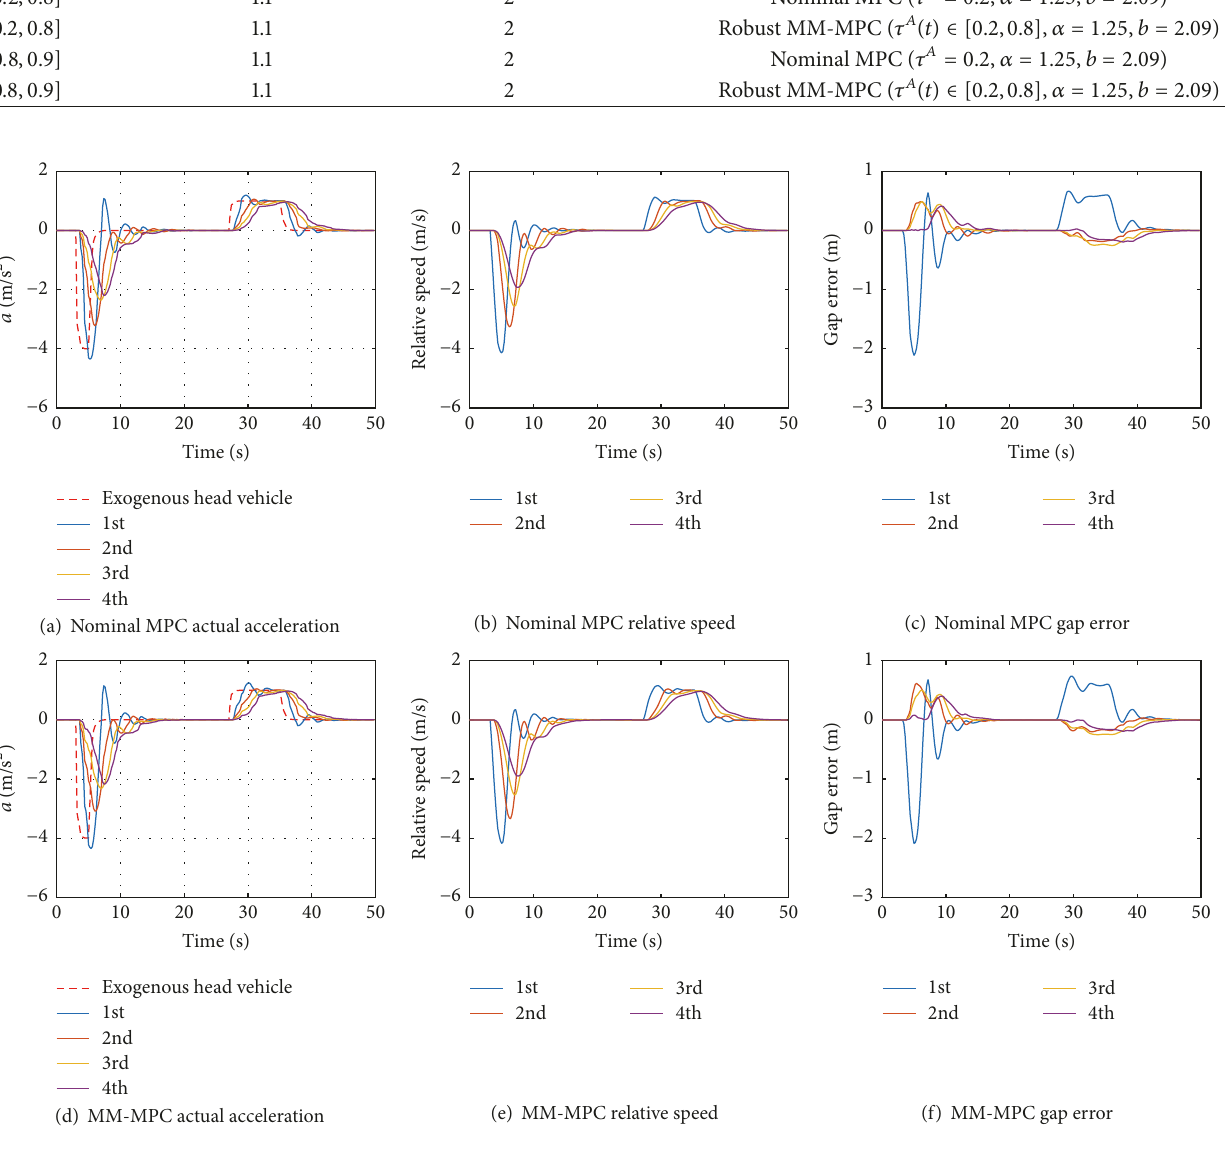
Figure 2: Comparison of nominal MPC ( 𝜏 𝐴 = 0.2 s) and MM-MPC (designed with 𝜏 𝐴 (𝑡) ∈ [0.2,0.8] s) for homogenous platooning control while actual 𝜏 𝐴 (𝑡) ∈ [0.2, 0.8]